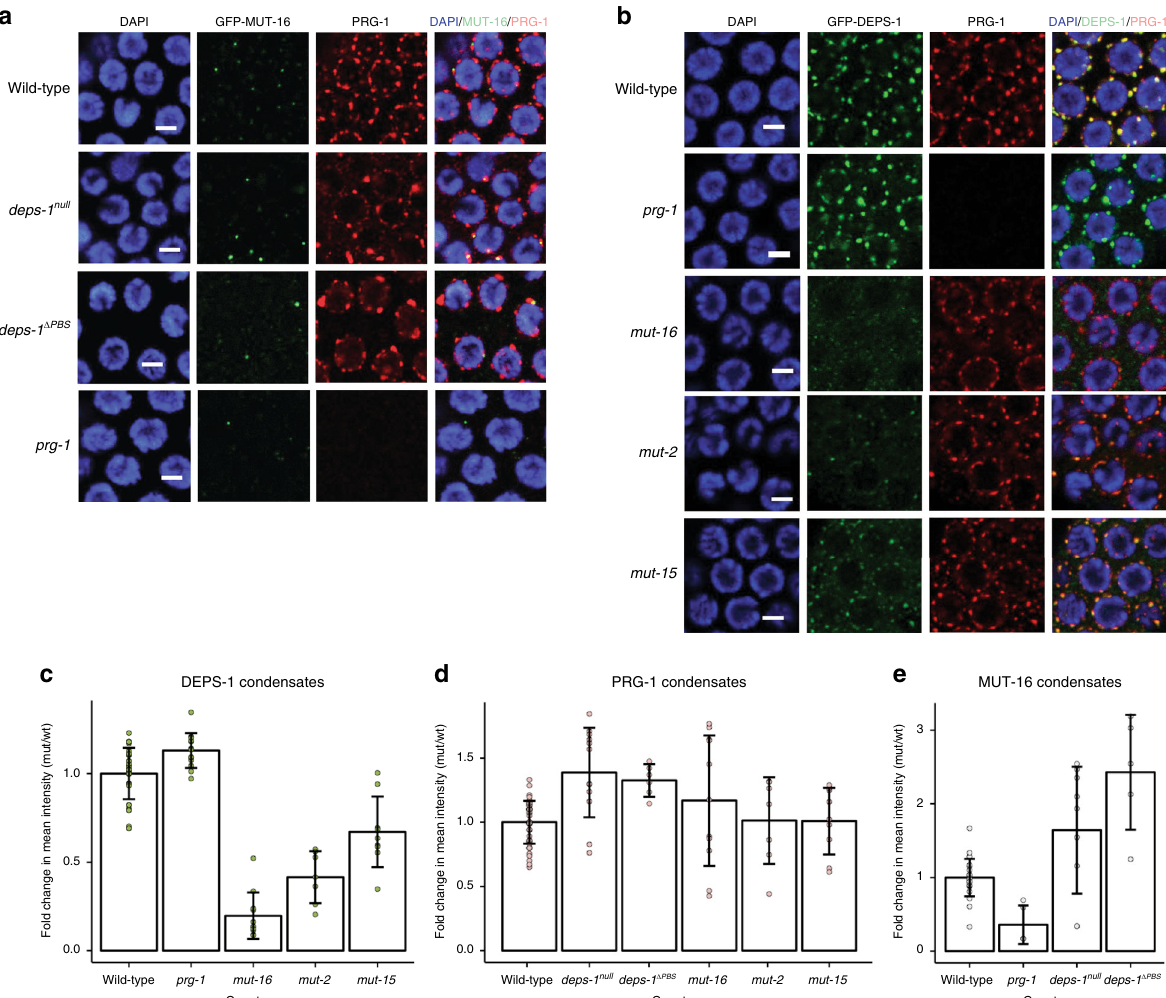
Fig. 3 Morphologies of PRG-1, DEPS-1 and MUT-16 condensates are interdependent. a GFP-MUT-16 and PRG-1 localisations were examined in prg-1 (n4357), deps-1 null (bn121) and deps-1 Δ PBS (mj605) mutants. The common genotypes of strains used are mut-16(pk710); gfp::mut-16(mgSi2) which is denoted as ‘ wild-type ’ . Additional mutations upon this common genotype are indicated on the left. C. elegans germlines were dissected and immunostained for GFP and PRG-1. Scale bar = 3 µ m. b GFP-DEPS-1 and PRG-1 localisations were examined in prg-1(n4357) , mut-16(pk710), mut-2(ne298) and mut-15(tm1358) mutants. ‘ wild-type ’ indicates the common genotype of gfp::deps-1(ax2063) among the strains used and additional mutations are indicated on the left. C. elegans germlines were dissected and immunostained for GFP and PRG-1. Scale bar = 3 µ m. c Fold change in DEPS-1 condensate density in wild-type (n = 41), prg-1 ( n = 13), mut-16 ( n = 11), mut-2 ( n = 7), mut-15 ( n = 9) animals. d Fold change in PRG-1 condensate density in wild-type ( n = 37), mut-15 ( n = 9), mut-16 ( n = 11), deps-1 null ( n = 12), deps-1 Δ PBS ( n = 3), mut-2 ( n = 7) animals. e Fold change in MUT-16 condensate density in wild-type (n = 25), prg-1 ( n = 5), deps-1 null ( n = 9), deps-1 Δ PBS ( n = 5) animals. c – e Data are presented as mean values± SD. Source data are provided as a Source Data fi